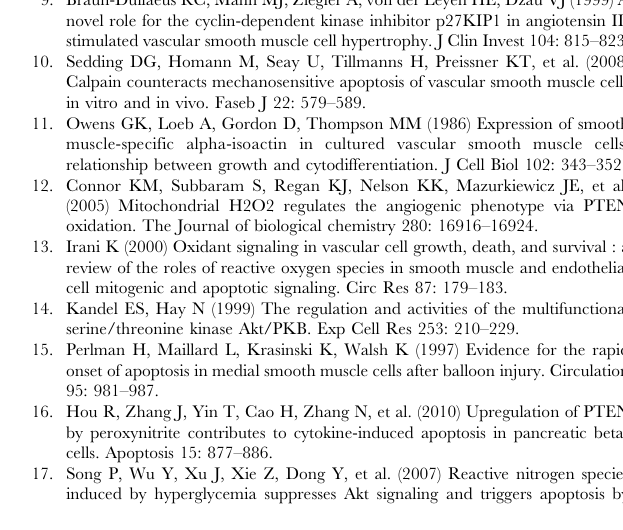
Figure S1 A , H&E-stained cross sections of an uninjured and an injured carotid artery 12 h after balloon injury are shown. In the injured artery, strongly damaged areas can be identified by the lack of nuclei (blue). B , Immunoreactivity of aSMA (green), PTEN (red) and nuclei (DAPI, blue) is shown in representative sections of an injured rat carotid artery 12 h after balloon injury. Immuno- reactivity of PTEN (green), apoptotic nuclei (TUNEL, red) and of nuclei (blue) is shown in undilated vessels. C , Representative pictures showing the squared area of a whole vessel cross section (lower panel) in 4 6 magnification. The lesions can be distin- guished from the intact vessel area due to the reduction of DAPI- stained nuclei and the TUNEL + nuclei in the severely damaged region. Figure S2 A , PTEN-expression is upregulated following incu- bation of VSMC with H 2 O 2 for 12 h. The simultaneous incubation with catalase but not with inactivated catalase prevented the H 2 O 2 -induced upregulation of PTEN protein levels. B , Following 20 min of H 2 O 2 incubation (500 nM), almost all of the cellular PTEN protein- content is oxidized as indicated by immunoblotting and a band shift seen in non-reducing gels. In contrast, incubation of VSMC with H 2 O 2 for 12 h increases total PTEN protein content but does not result in a prominent oxidation (band shift) of the protein. PTEN expression in dilated arteries is robustly increased at 12 h following injury, but no significant oxidation of the protein (no band shift) is detected by immunoblotting under non-reducing